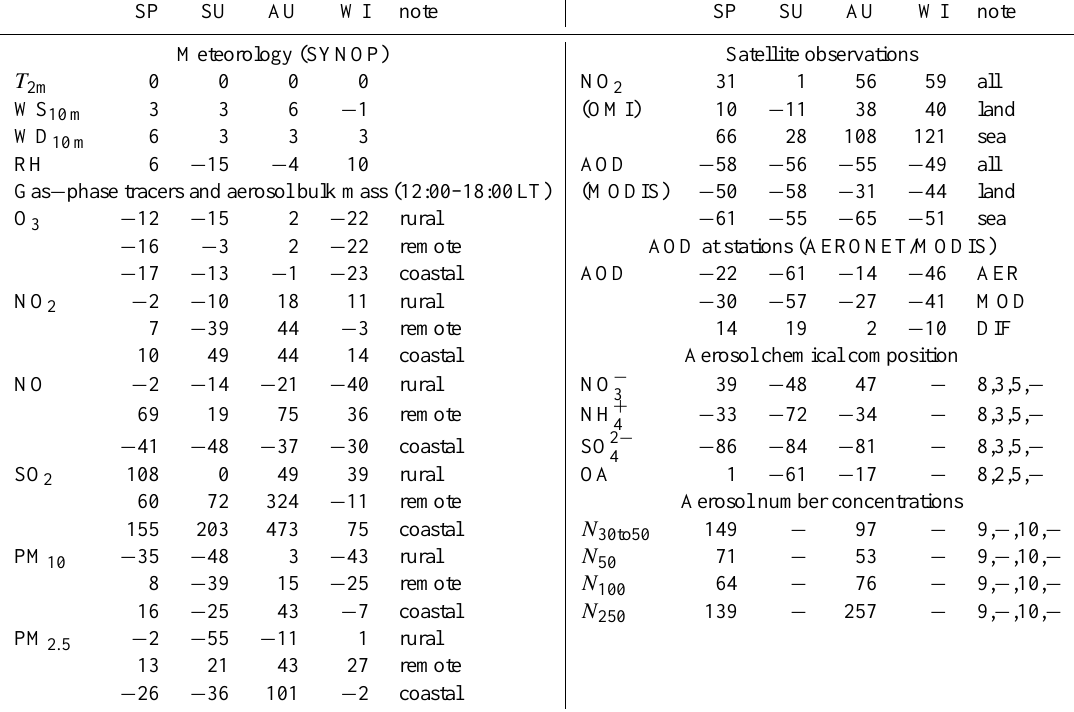
Table 2. Normalized mean biases (%) in spring, summer, autumn and winter (SP, SU, AU, WI) for SYNOP and AIRBASE datasets, satellite comparisons and aerosol datasets. Satellite biases are the mean over all grid points, only land points and only sea points. AERONET comparison shows biases model – AERONET (AER), model – MODIS (MOD) at AERONET station, and MODIS – AERONET (DIF). AMS and EUSAAR biases are the mean over all stations presented in the evaluation, the number of stations in each period is given in